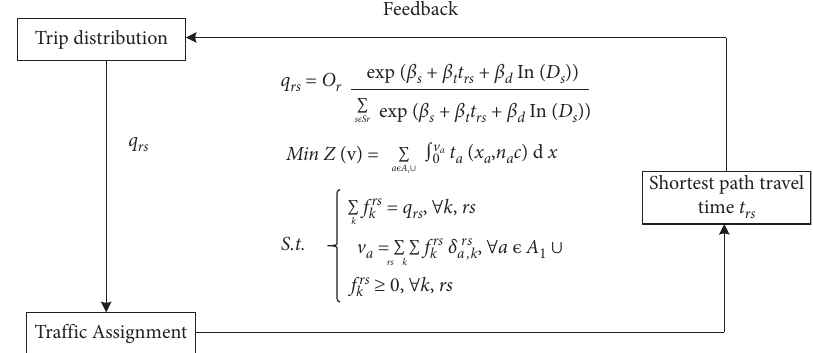
Figure 2: The feedback process of lower level